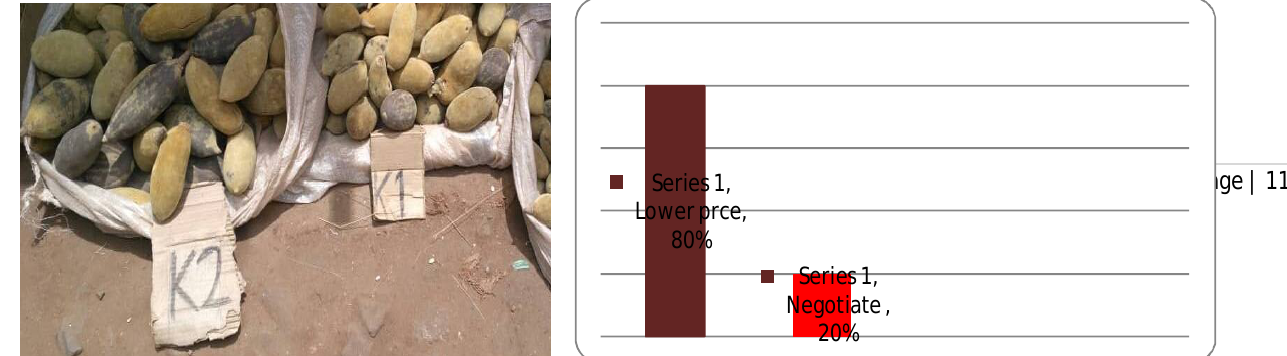
Figure 3: Baobab sold at a very Low price Figure 4: Baobab sales